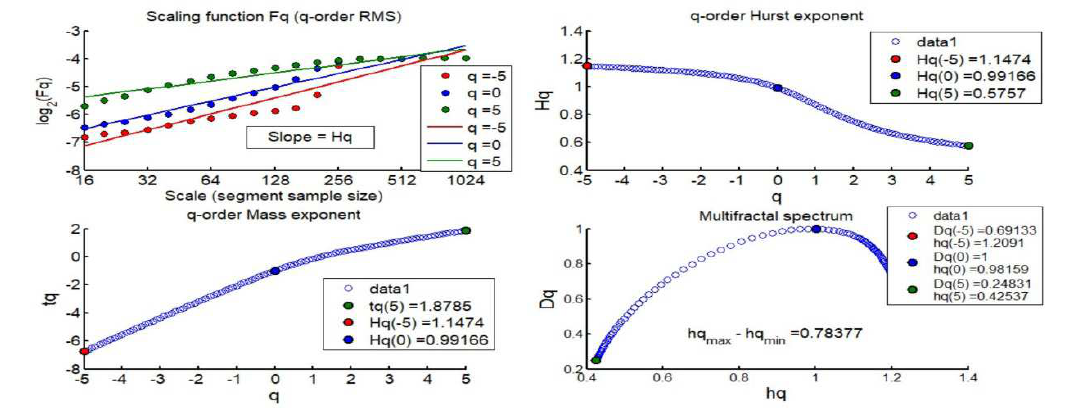
Figure A10. Hurst exponent value Hq (5) in 2020